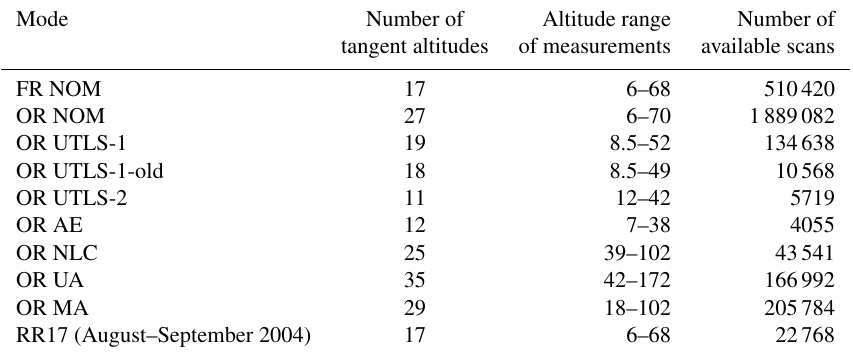
Table 1. List of the MIPAS observation modes used for the level2-v8 database with their vertical coverage and number of available scans. Mode Number of Altitude range of